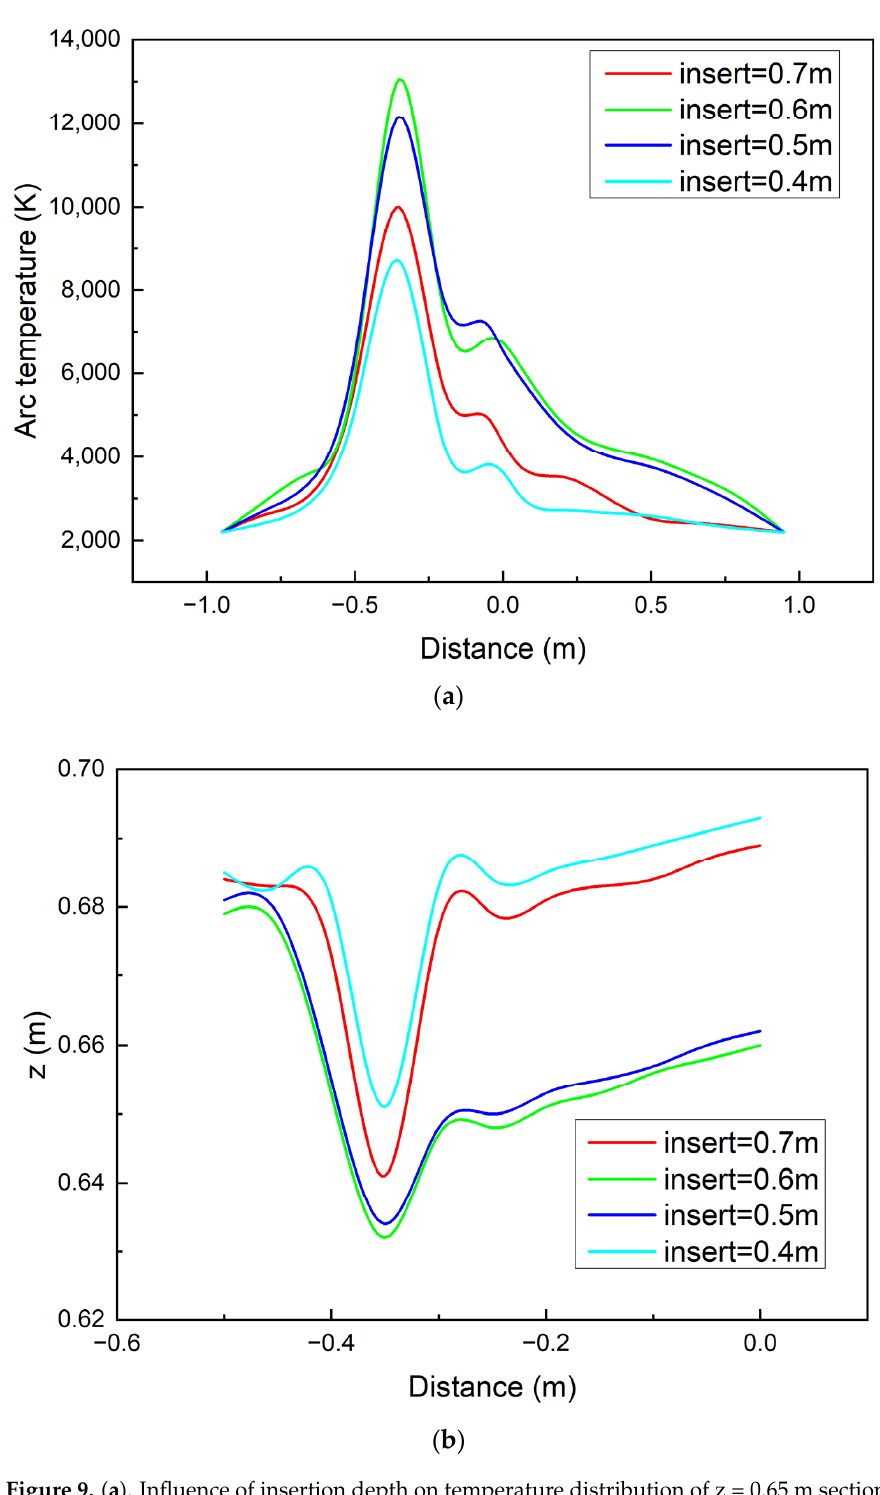
Figure 9. ( a ). Influence of insertion depth on temperature distribution of z = 0.65 m section. ( b ) Effect of penetration depth on arc length.